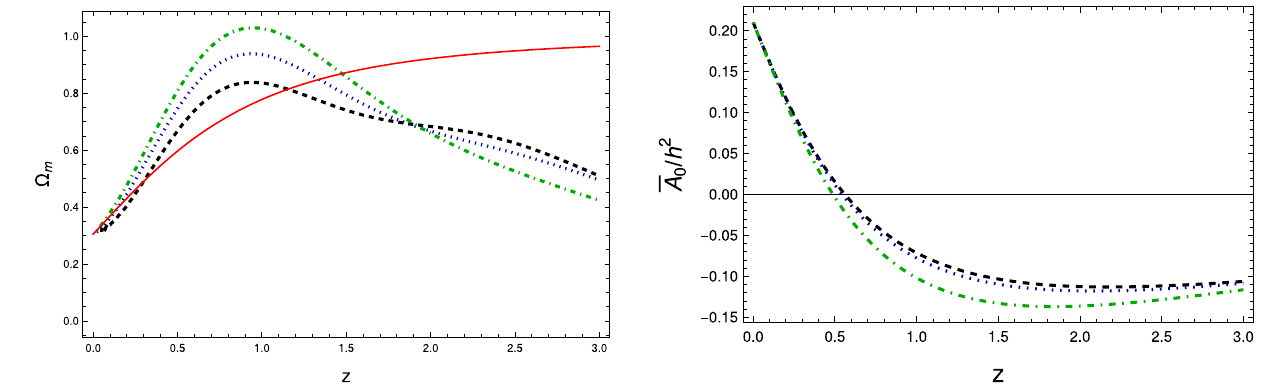
Fig. 6 Thedustdensityabundance (cid:18) m ( z ) (leftpanel)andthere-scaled temporal component of the Weyl vector A 0 ( z ) (right panel) for the gen- eral conformally invariant Weyl geometric case (95), for lower 2 σ limit